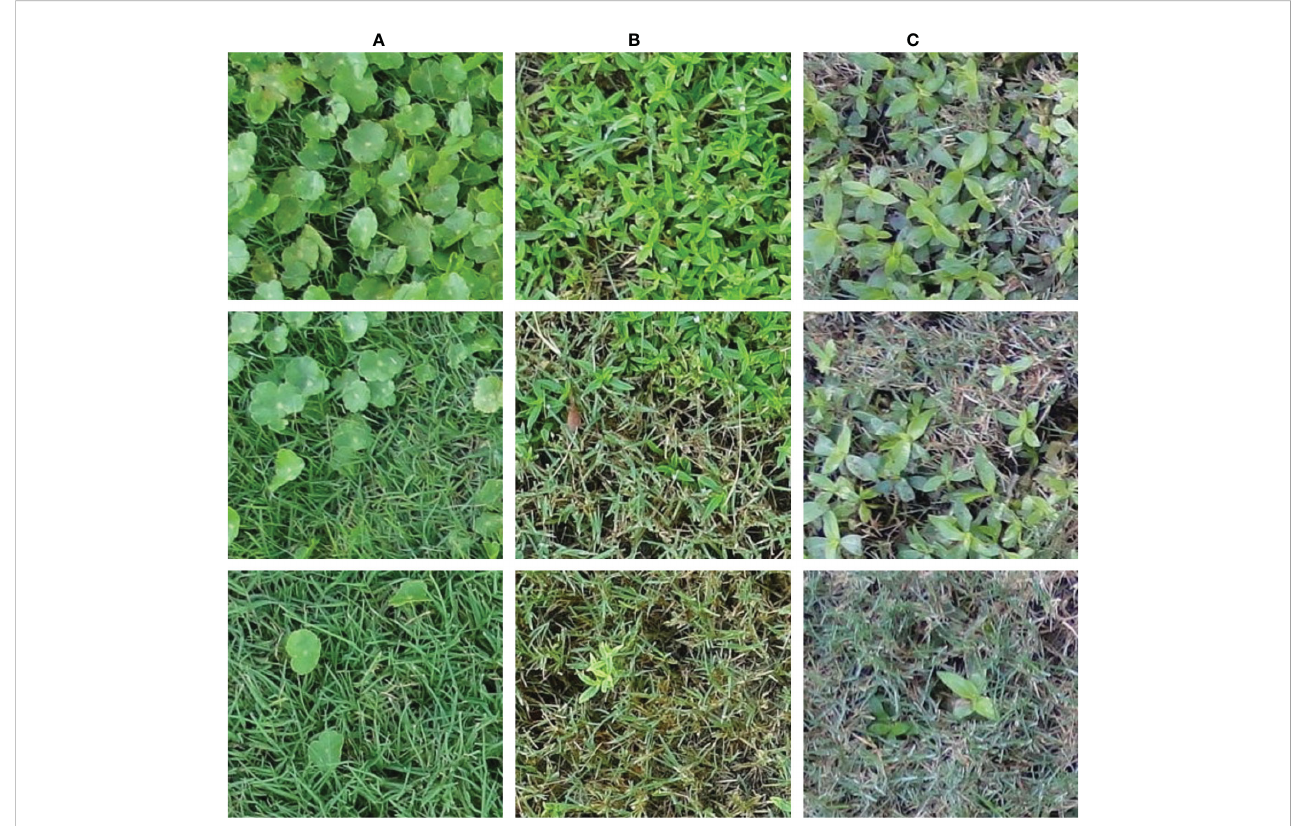
FIGURE 2 The training and testing sub-images of dollarweed (A) , old world diamond- fl ower (B) , and Virginia buttonweed (C) at different growth stages and densities.